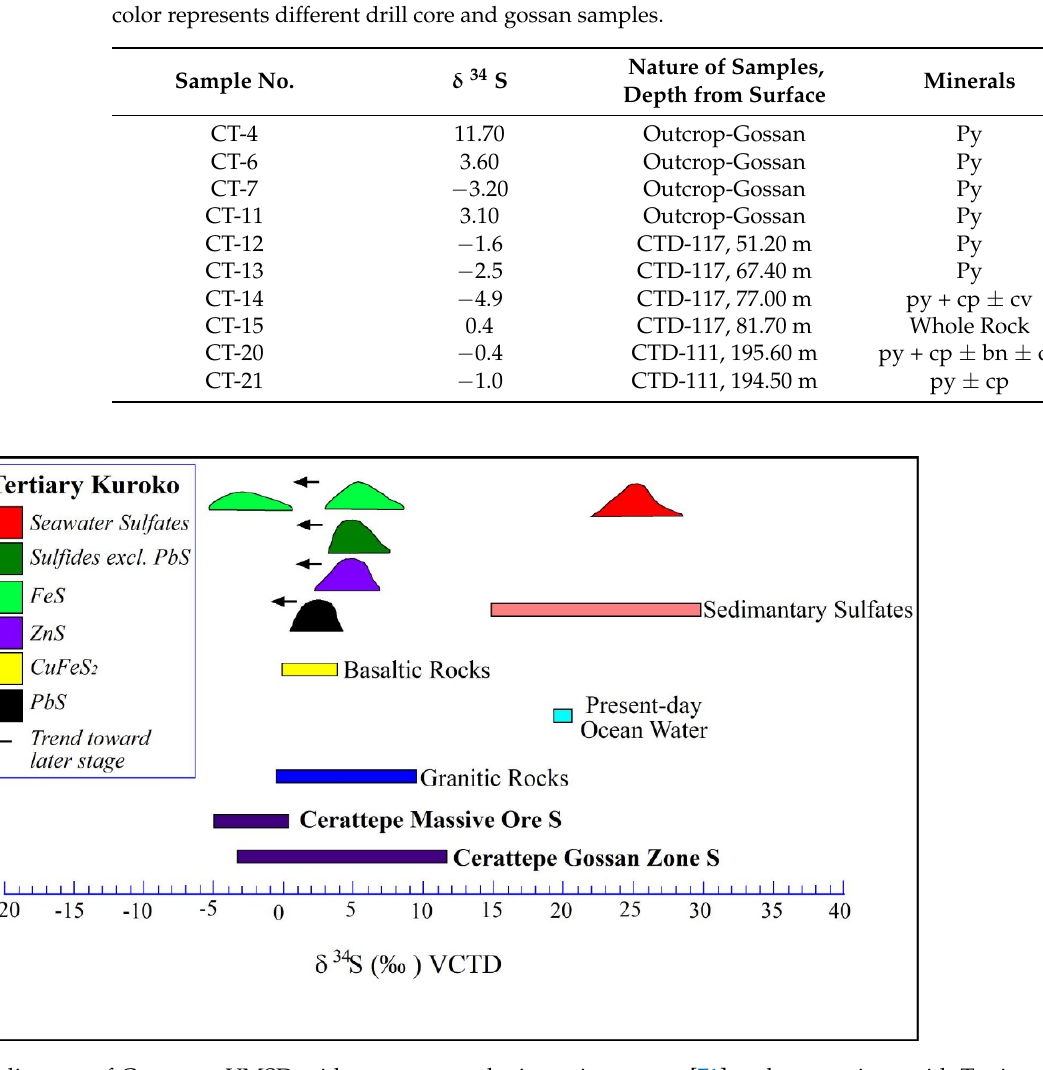
Figure 14. δ 3 4 S diagram of Cerattepe VMSD with common geologic environments [71] and comparison with Tertiary Kuroko types [70].